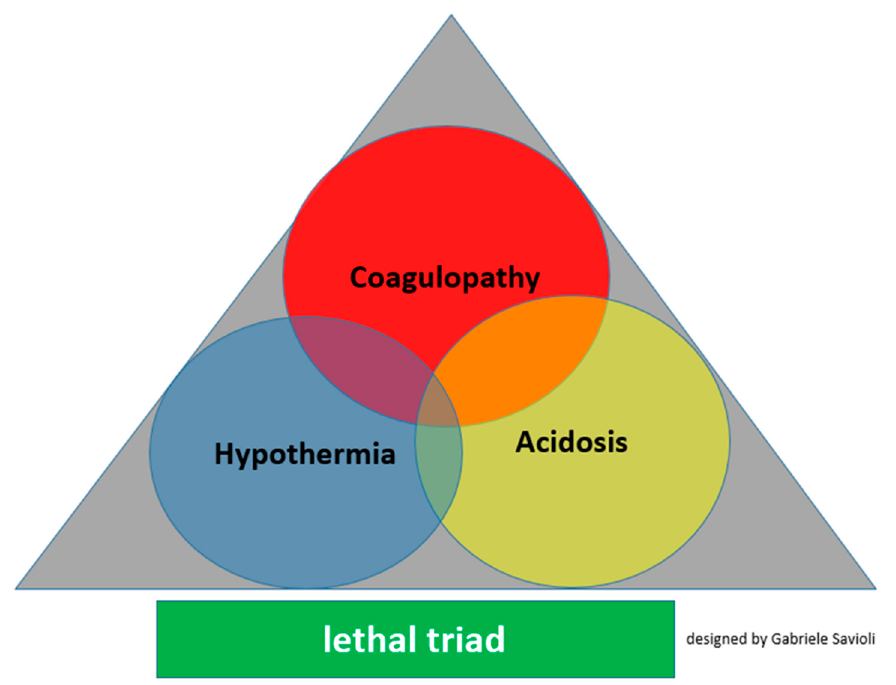
Figure 1. Lethal triad for major trauma.